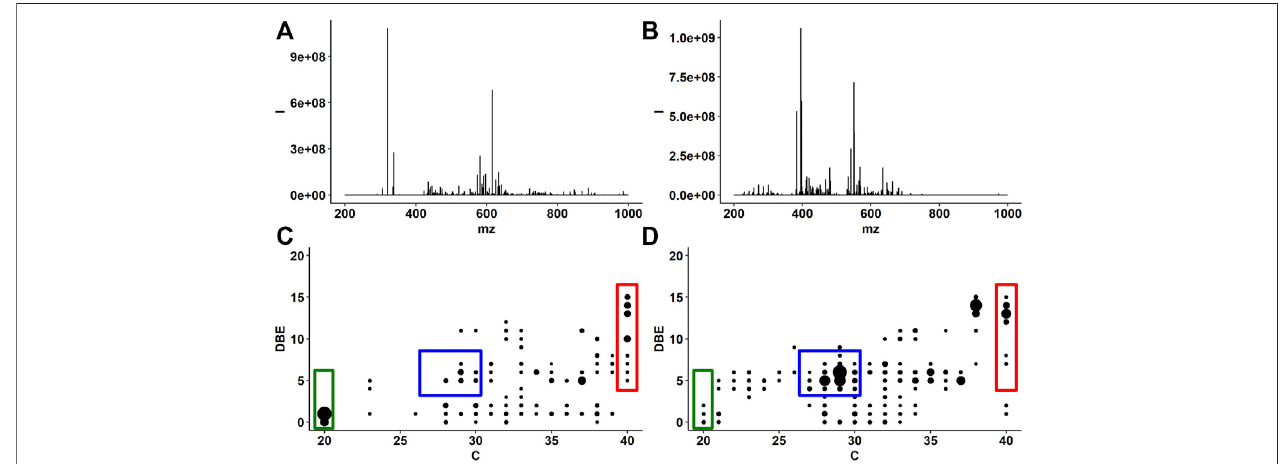
FIGURE 3 | FT-ICR mass spectra of the unsaponi fi able compounds by ESI (A) and APCI (B) . Plots of DBE vs. number of carbon atoms for the O 1 – O 3 -containing compounds by ESI (C) and hydrocarbon-O 2 compounds by APCI (D) . Ions observed in APCI are [M + H – H 2 O] + ions and were veri fi ed by analysis of sterol standards. Phytol, sterol, and pigment regions are indicated in green, blue, and red boxes, respectively, in (C) and (D) .